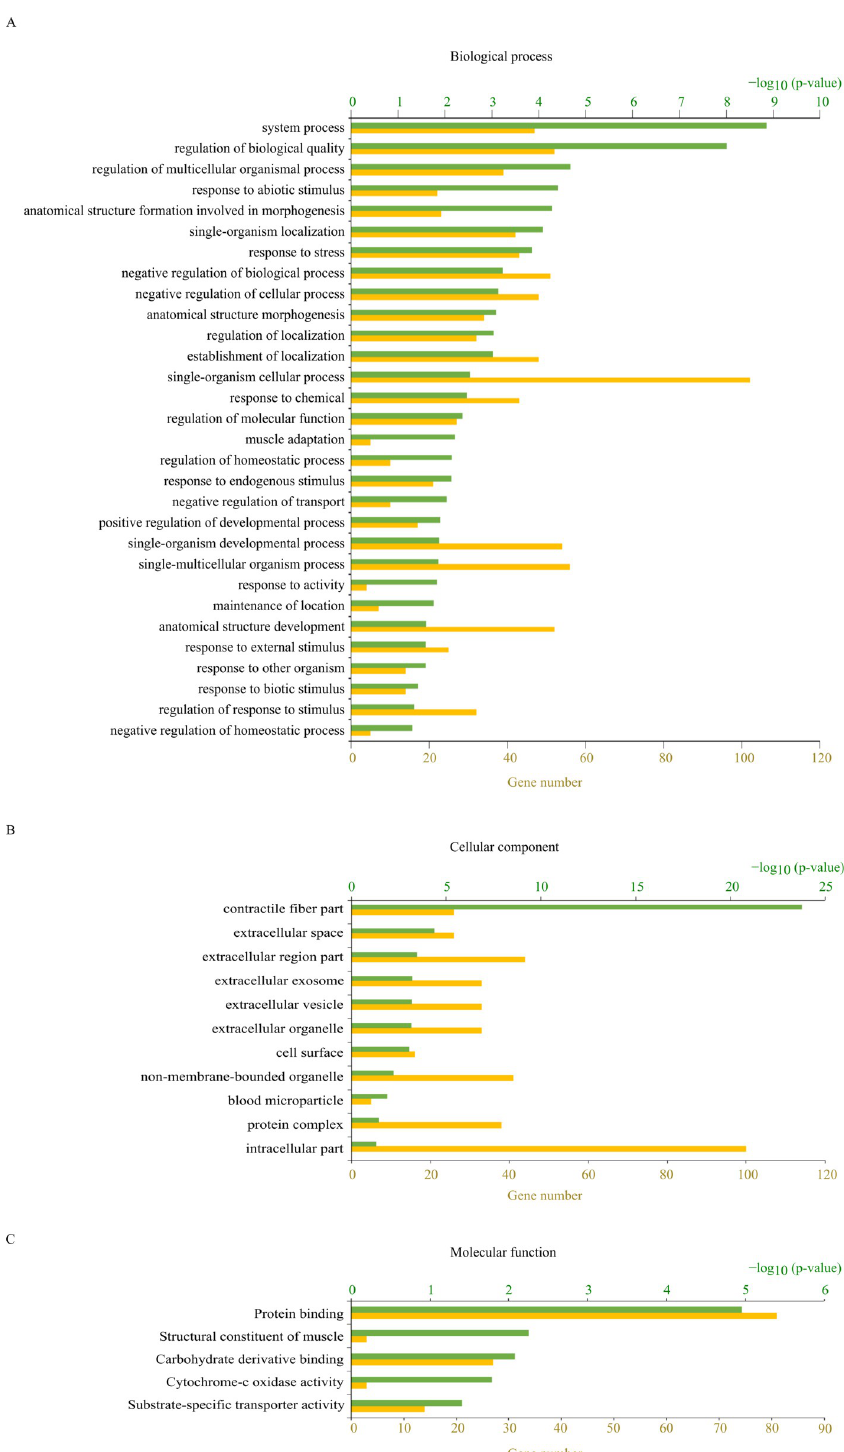
Fig 3. Results of a functional enrichment analysis of genes differentially expressed between nintedanib- and vehicle-treated mice conducted within the Database for Annotation, Visualization, and Integrated Discovery (DAVID). Functional enrichment was examined within the categories of (A) biological process, (B) cellular component, and (C) molecular function; p -values less than 0.05 were considered significant, and the number of genes annotated in each functional category is